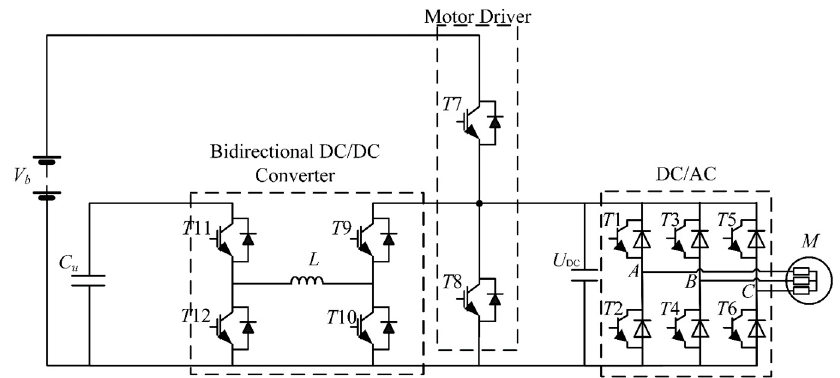
Figure 7. The main electrical circuit of the HES.